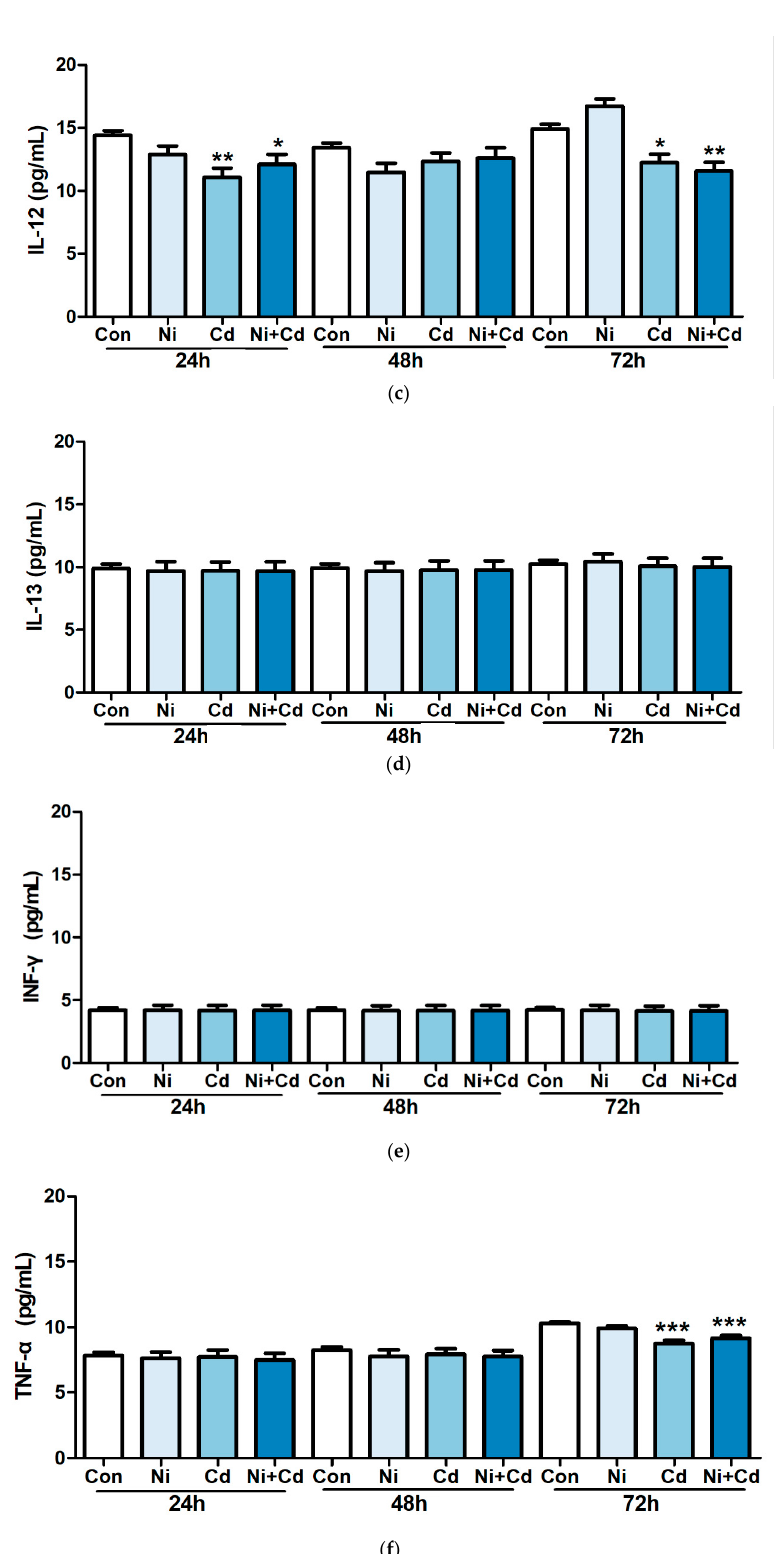
Figure 3. Concentration of cytokines in Raw264.7 murine macrophage cells after exposure to 50 nM of nickel (Ni), 10 nM of cadmium (Cd), and a Ni–Cd mixture. ( a ) IL-4, ( b ) IL-10, ( c ) IL-12, ( d ) IL-13, ( e ) INF- γ , ( f ) TNF- α . Bars represent means ± standard deviation. *** p < 0.001, ** p < 0.01, * p < 0.05 vs. control.